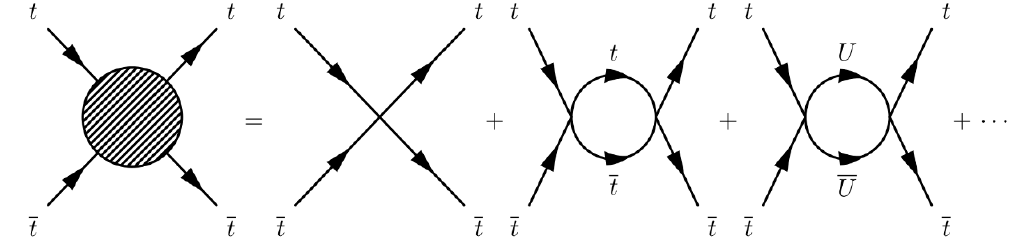
Figure 1 . The (cid:22) tt scattering amplitude in the J P = 0 + channel with the four-fermion kernel given by the terms in eq.